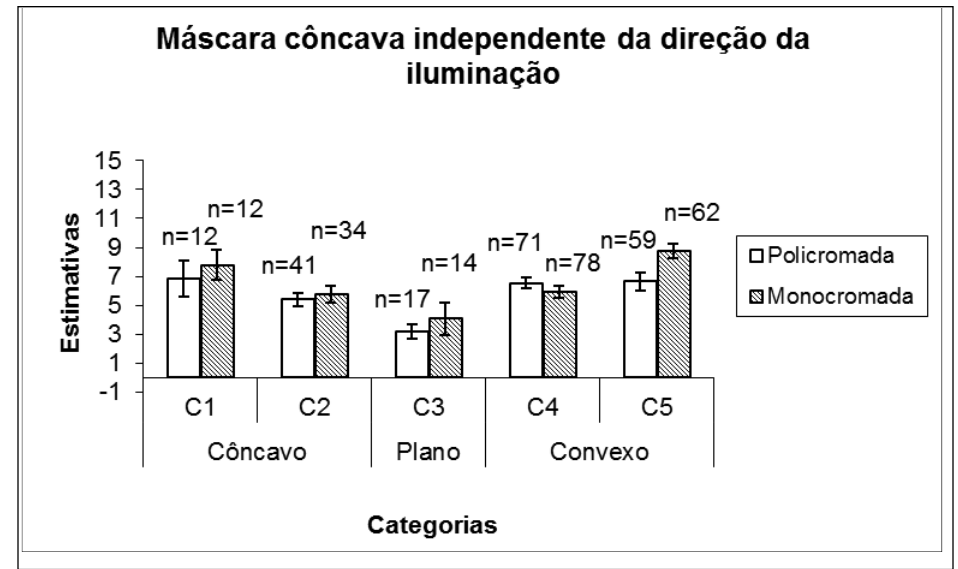
Figura 2 . Estimativas médias e erros-padrão da profundidade percebida entre o nariz e a base da face da máscara côncava monocromada e policromada, independente da direção da fonte de iluminação, para as categorias: plenamente côncavo (C1), moderadamente côncavo (C2), plano (C3) moderadamente convexo (C4) e plenamente convexo (C5), por 40 participantes em 400 apresentações dos estímulos. n = frequência de respostas por